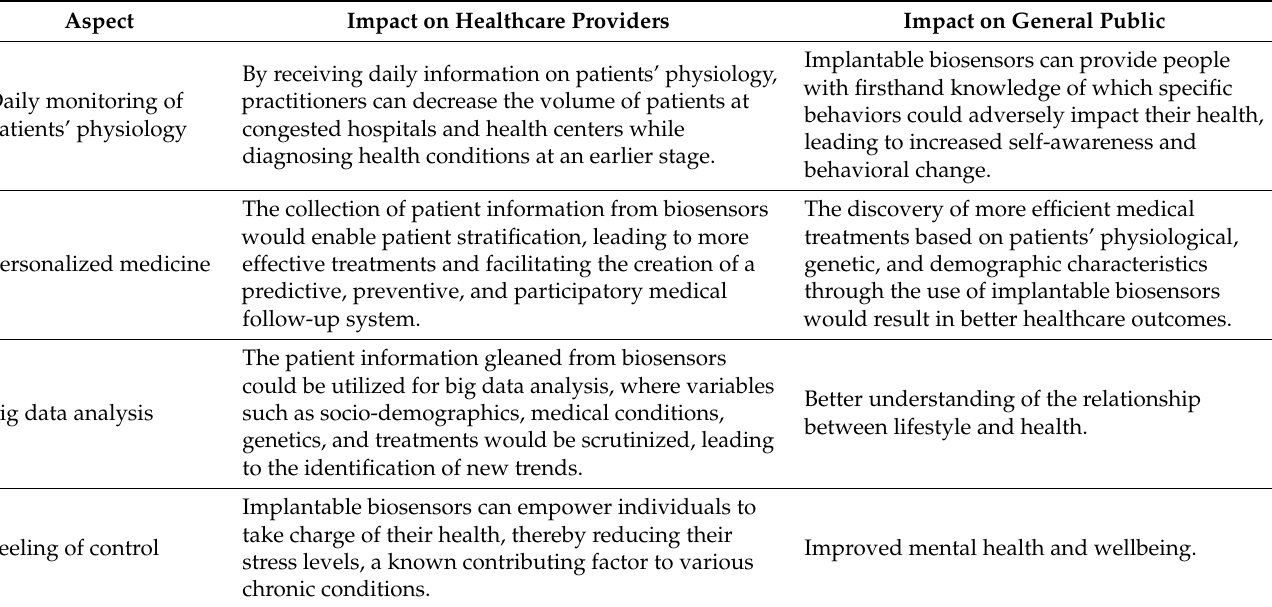
Table 3. Present and anticipated benefits of implantable biosensors for healthcare systems and the general public. Adapted from